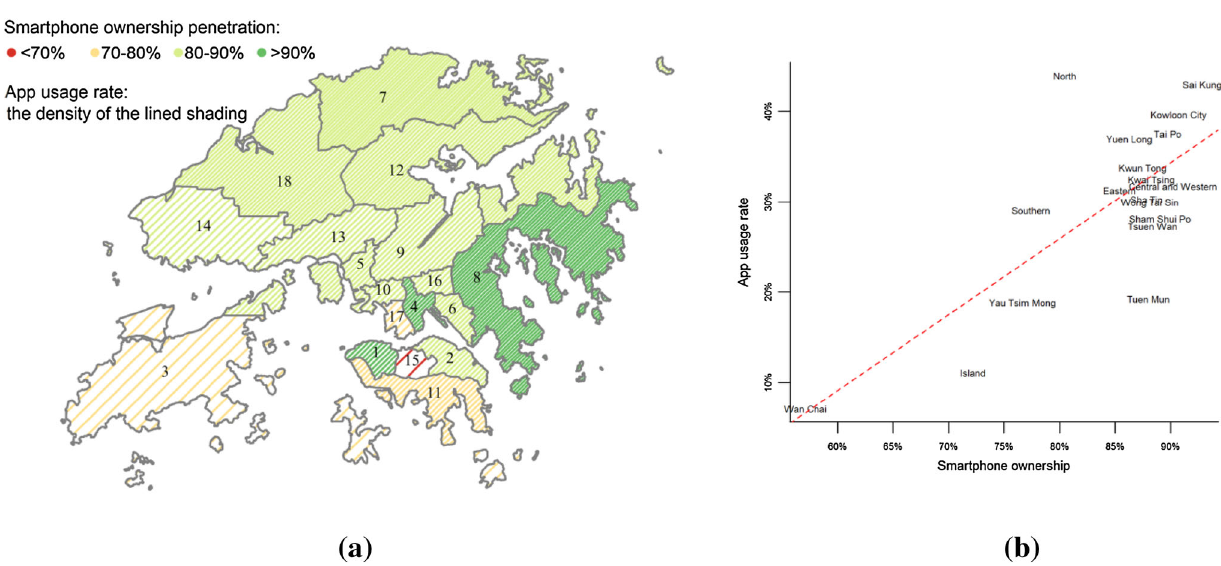
Fig. 2 Smartphone ownership penetration and usage rate of mobile apps as the main source of weather information (app usage rate) in Hong Kong by district in January/February 2016. Note a the numbers represent the 18 districts (in alphabetical order): 1 Central